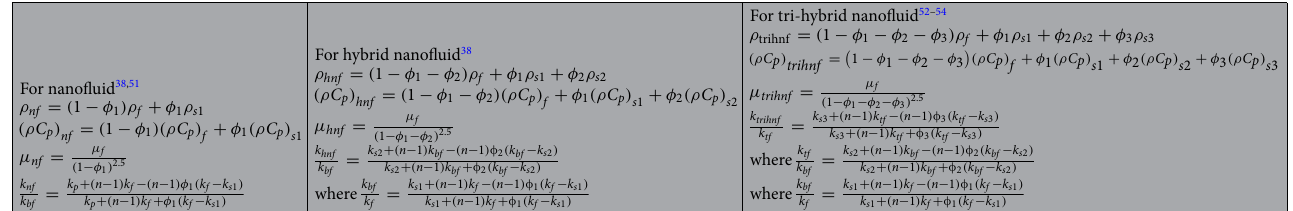
Table 1. Description of some dimensionless quantities.